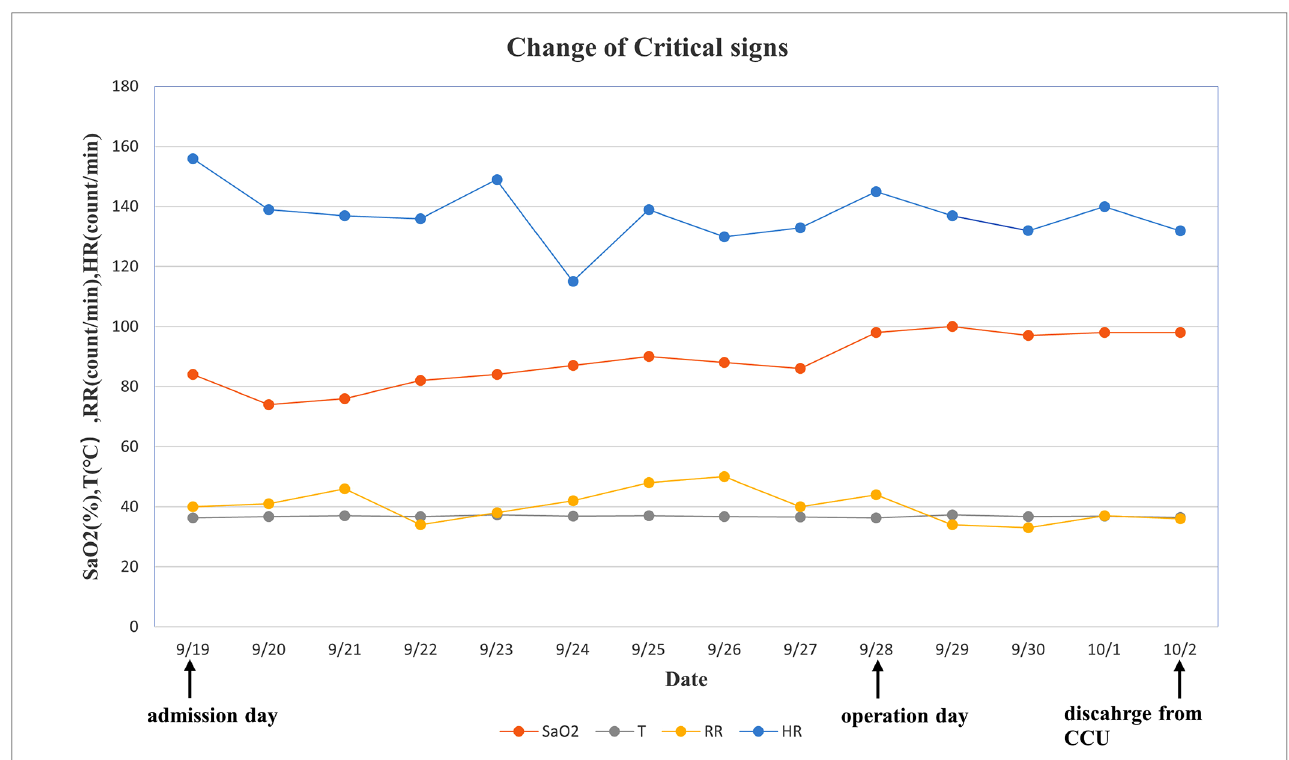
FIGURE 4 Change of critical signs of the patient. We observed that SaO 2 increased signi fi cantly after surgery. SaO 2 , oxygen saturation; T, temperature; RR, respiratory rate; HR, heart rate.